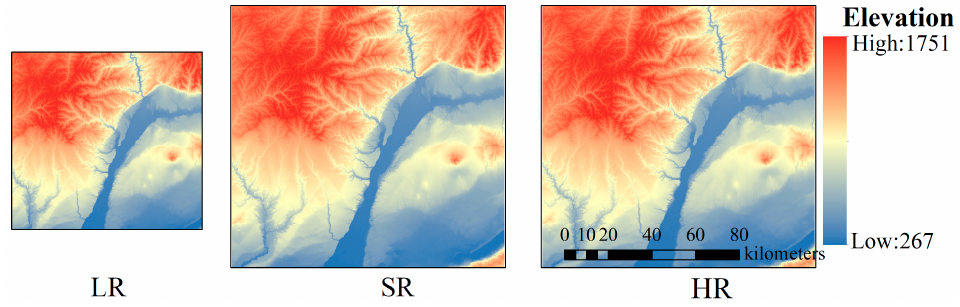
Figure 12. Results after reconstruction of a test area with the resolution of 25 m as an example.